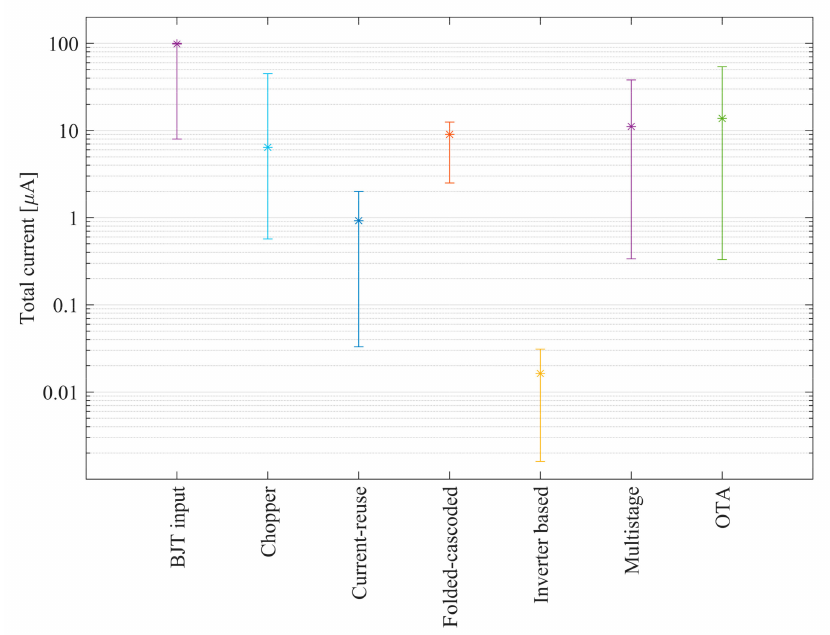
Figure 4. Average total current of the different amplifier categories and the published maximum and minimum values.